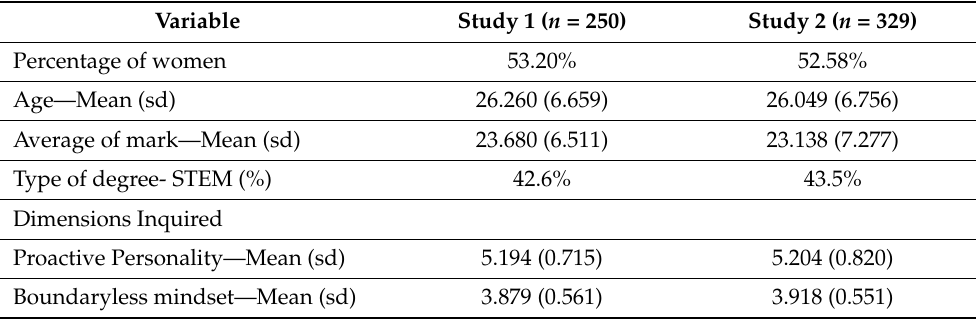
Table 1. Descriptive